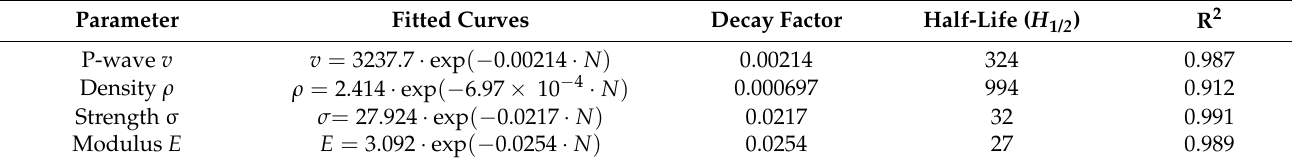
Table 2. Relationships among the physical and mechanical parameters with F-T cycle. Parameter Fitted Curves Decay Factor Half-Life ( H 1/ 2 ) R 2 P-wave v v = 3237.7 · exp ( − 0.00214 · N ) 0.00214 Density ρ Strength